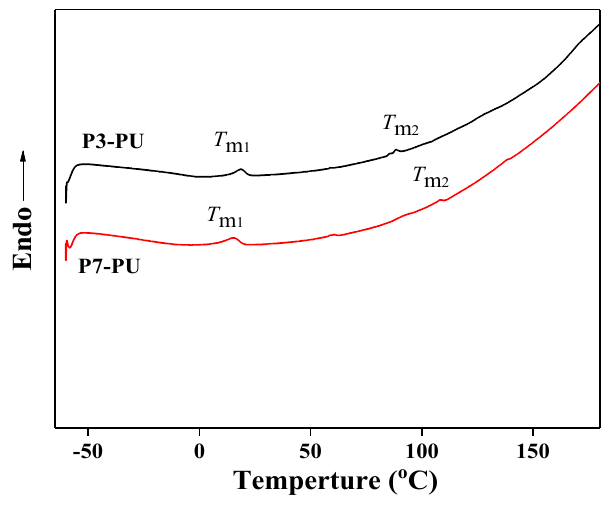
Figure 6. Atomic force microscopy (AFM) phase image of P7-PU . The scale bar is 40 nm.